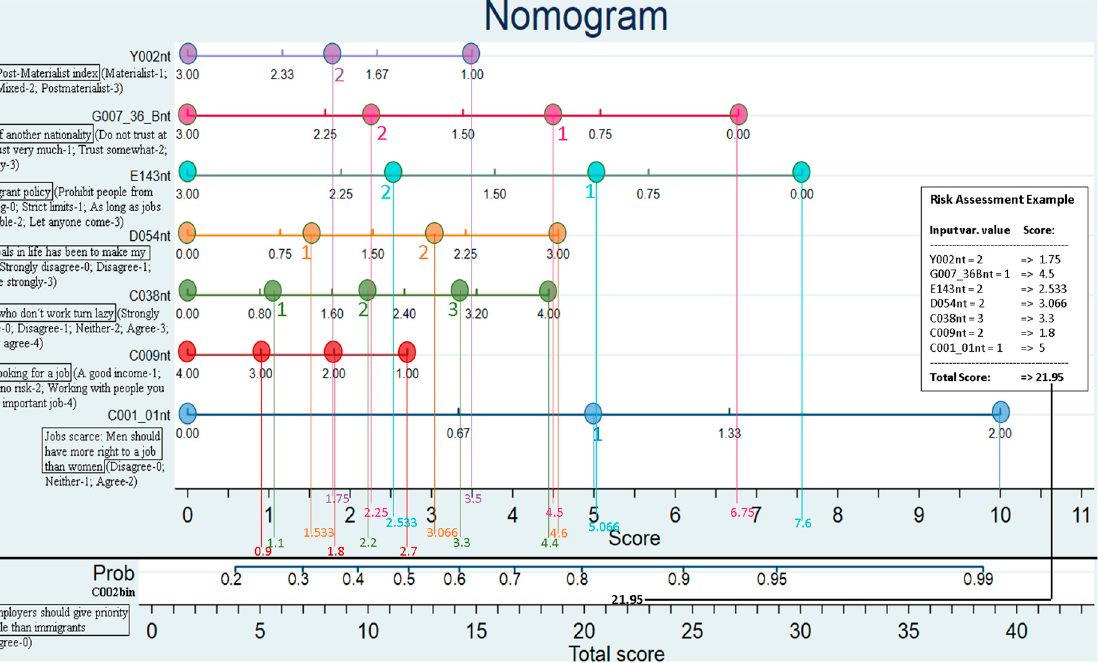
Figure 3. Risk prediction nomogram corresponding to the most resilient predictors (generated using the nomolog command in Stata).